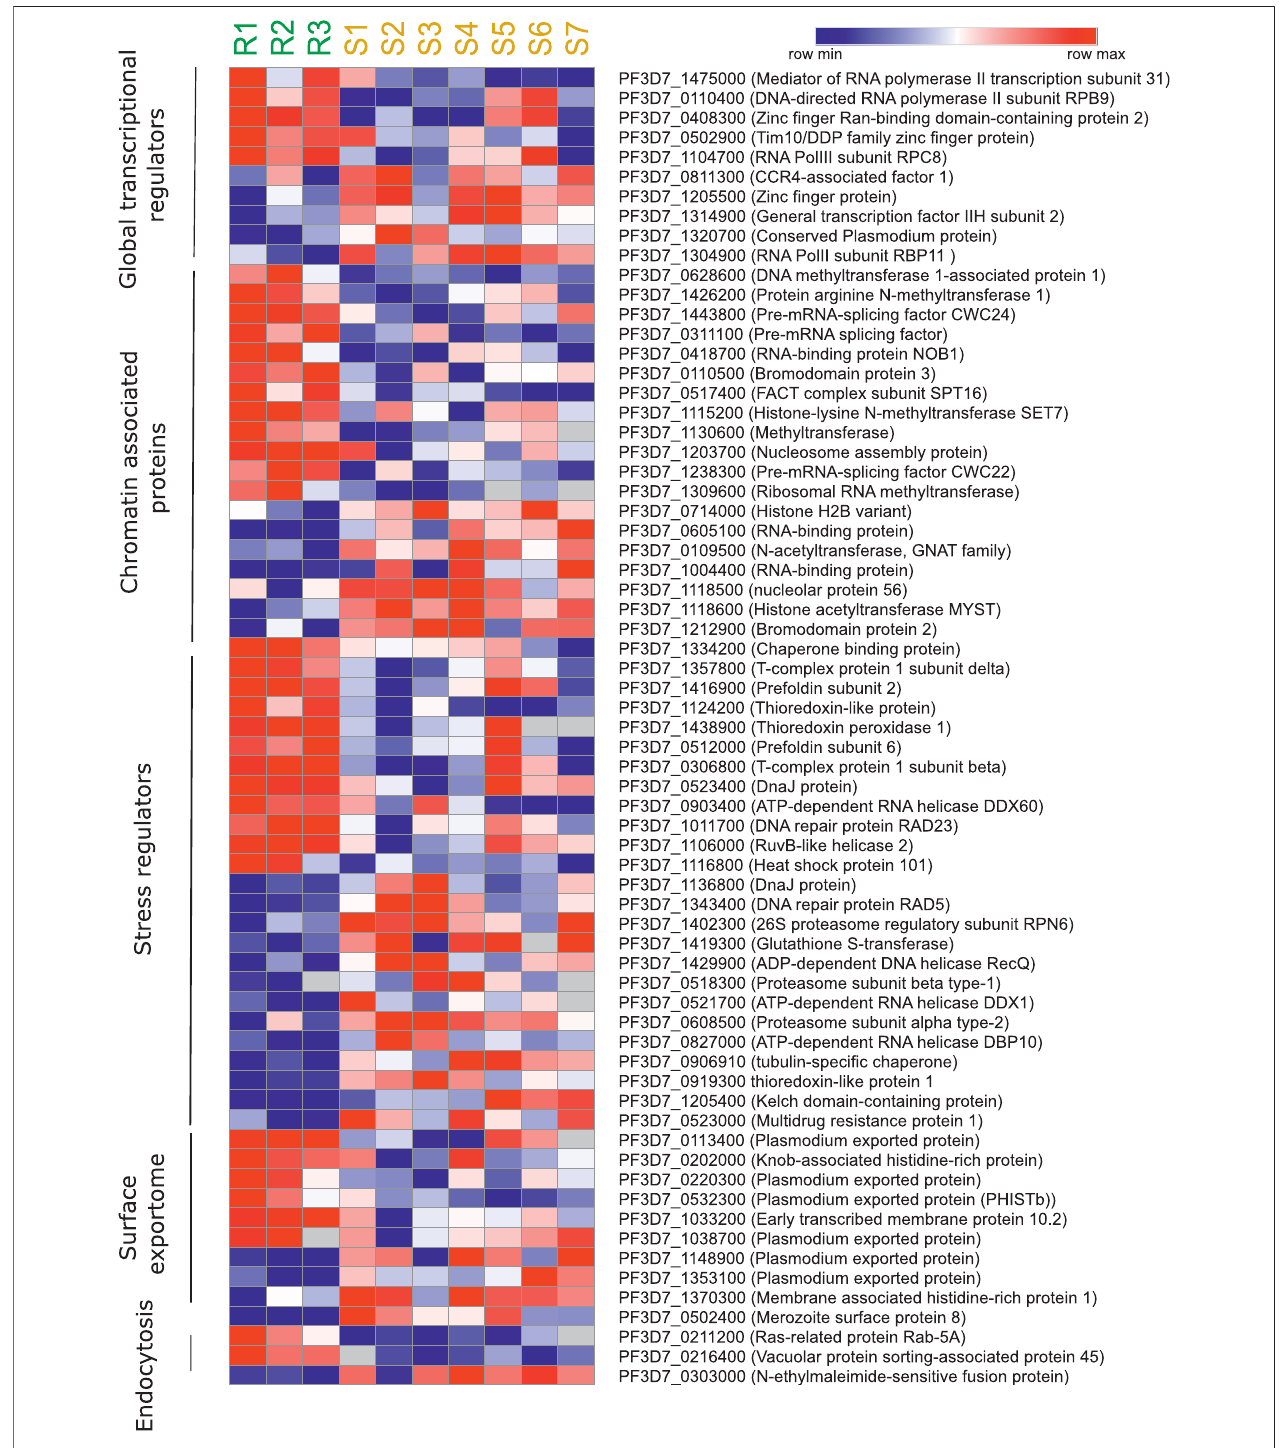
FIGURE 4 | Artemisinin resistance transcriptome of different biological pathways. Heatmap representing the deregulated expression of select genes from key biological pathways in Plasmodium contributive to artemisinin resistance. The heatmap is generated from transcriptomic dataset of Mok et al., 2011 study comparing three artemisinin-resistant and seven artemisinin-sensitive parasite isolates. The genes were selected on the basis of their deregulation in this dataset and at least one other transcriptomic dataset that we reviewed (Mok et al., 2015 and Rocamora et al., 2018).